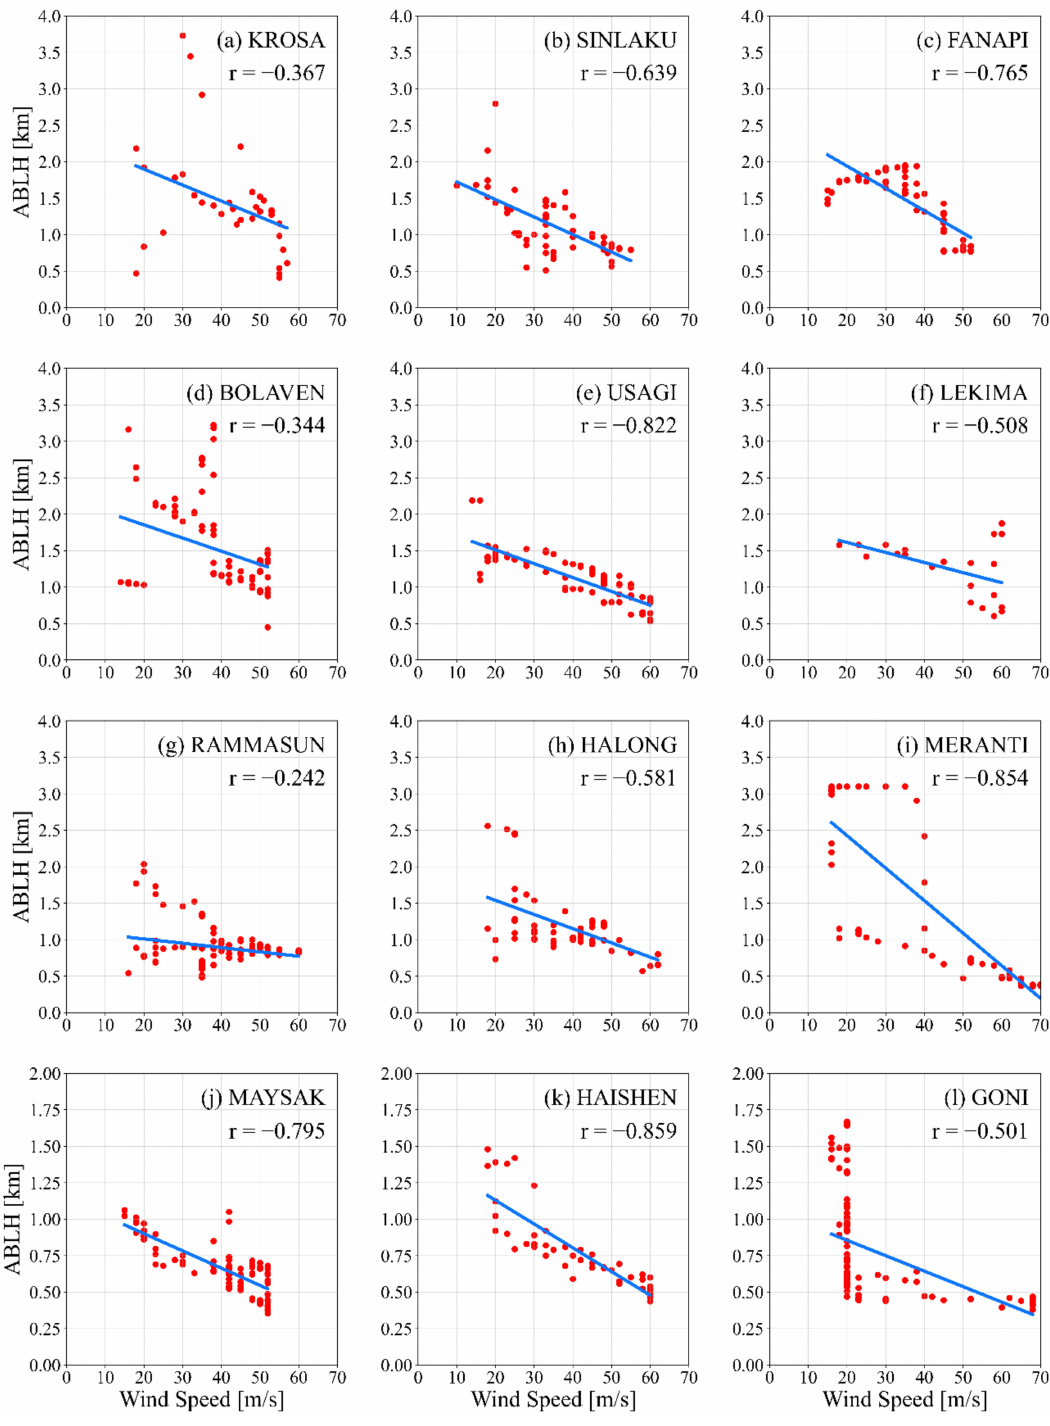
Figure 10. The relationship between the ABLH and wind speed during typhoons in this study. The correlation coefficient between the ABLH and wind speed of each typhoon is represented by r and marked in each subfigure. ( a – l ) represent the results of each typhoon arranged in the order of twelve